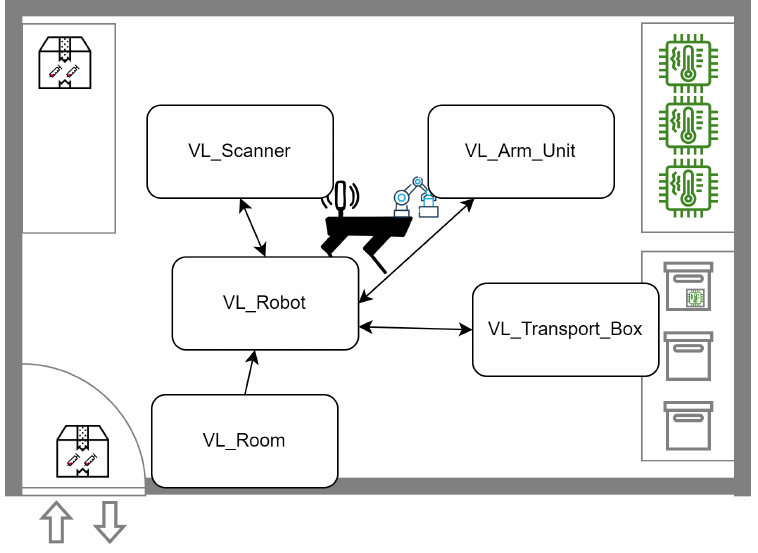
Figure 4. General modeling